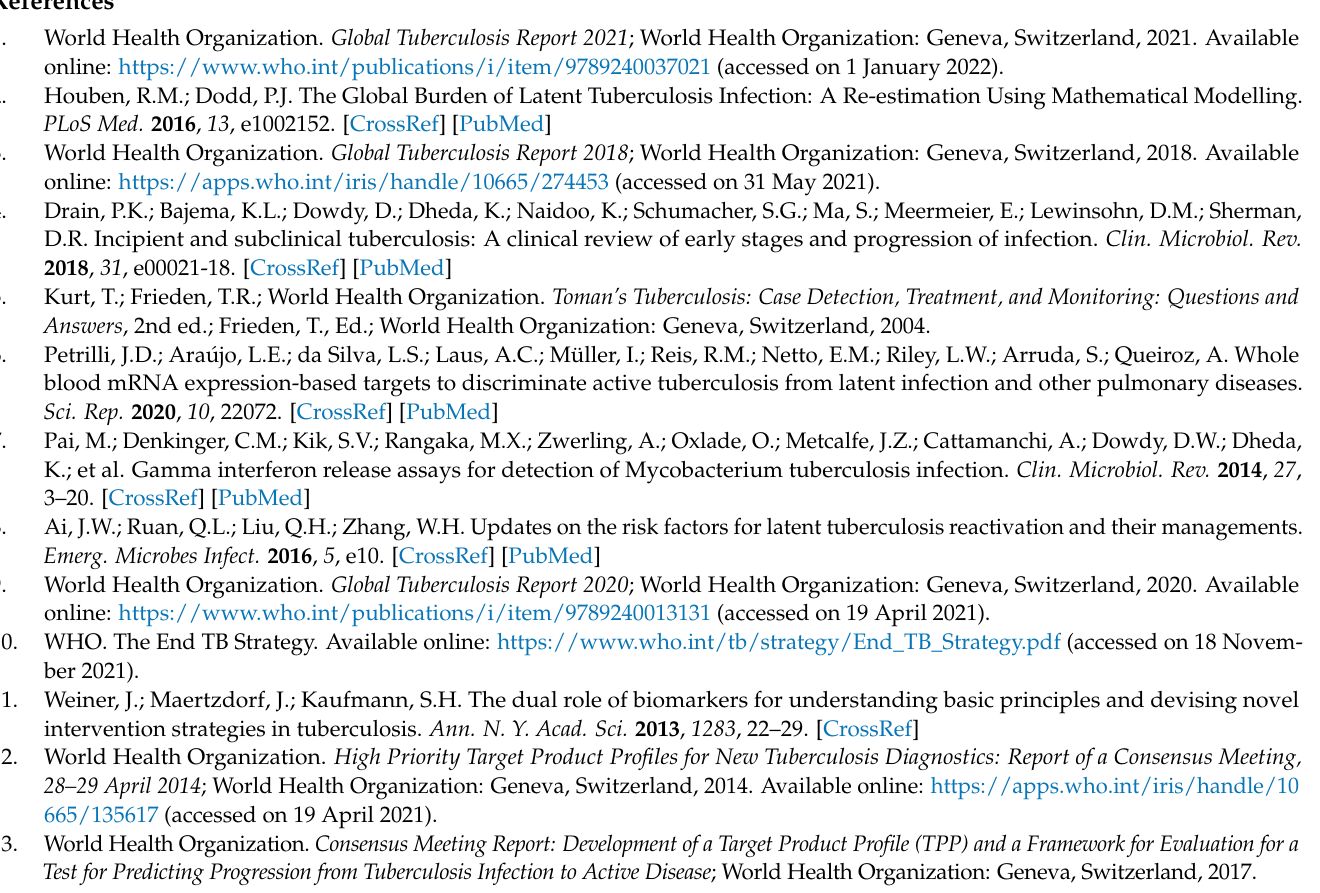
Figure S2. Heatmap of downregulated genes in ATB vs.